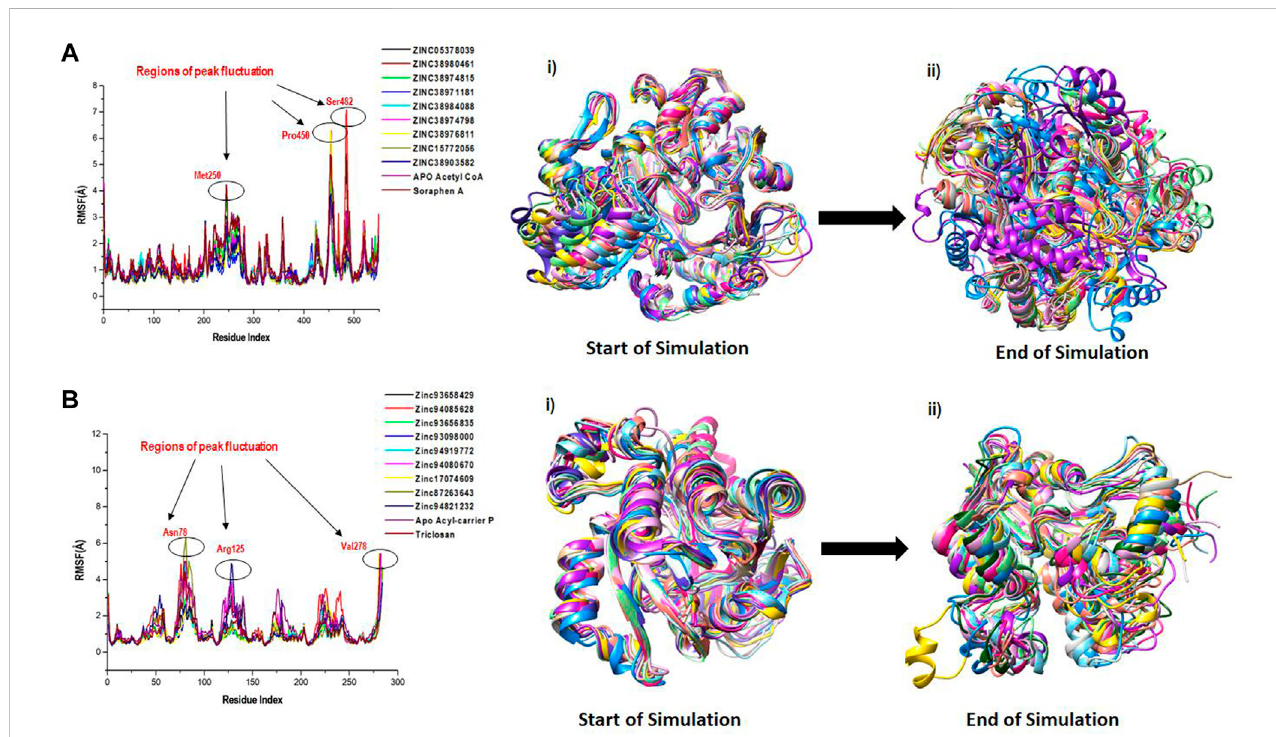
FIGURE 6 A plot of residual fl uctuations in the unbound and bound (A) Acetyl co-enzyme A and (B) Acyl-carrier reductase enzyme. (i) Highlights the initial superimposed structures of all systems, and (ii) shows the various fl uctuations that occurred at the end of the